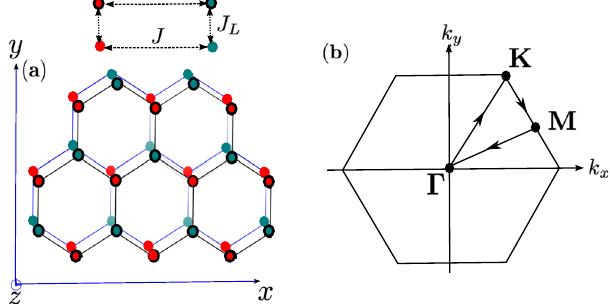
Figure 1. The honeycomb lattice and the Brillouin zone. ( a ) Schematic representation of AA-stacked bilayer honeycomb magnet on the plane perpendicular to the z -axis. ( b ) Brillouin zone of the system with different